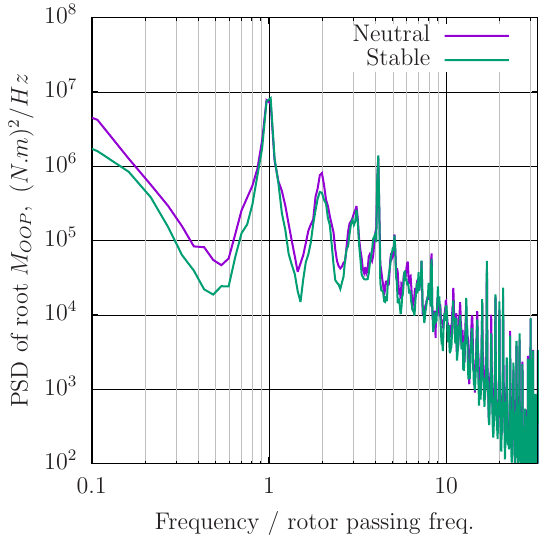
Figure 19. Secondary rotor simulation